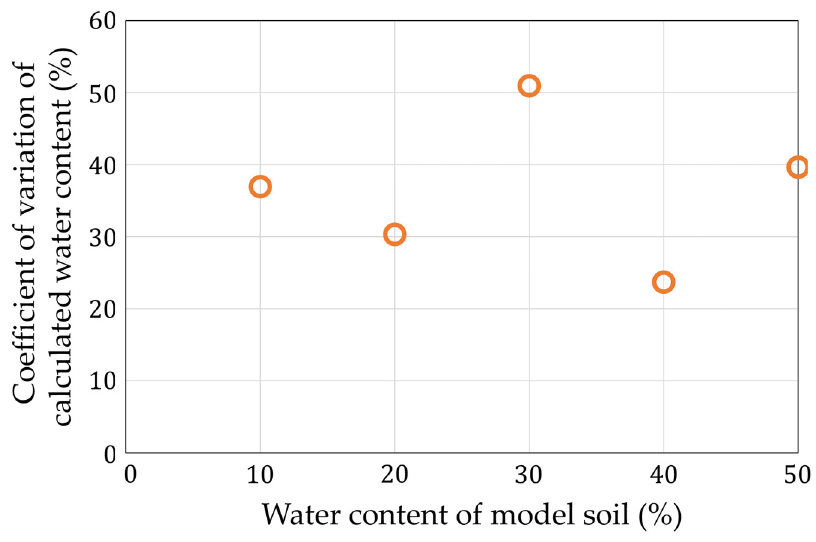
Figure 19. Coefficients of variation of Figure 17.